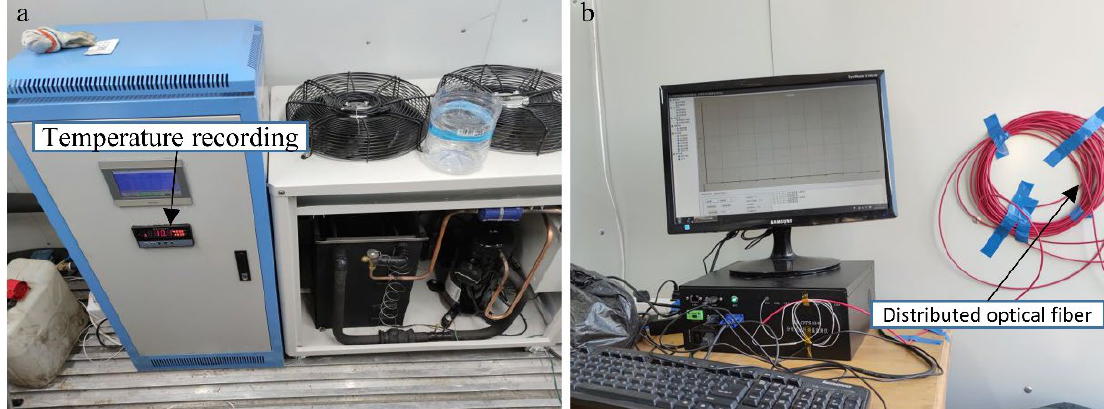
Figure 3. Field thermal response test system. ( a ) TRT module. ( b ) DTRT module.